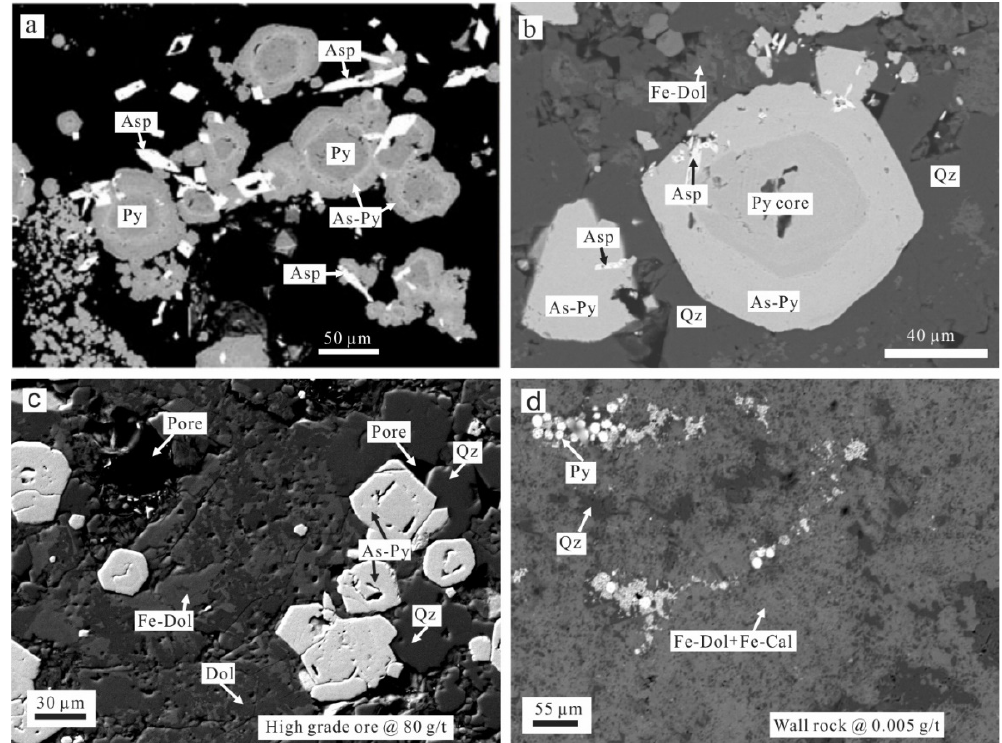
Figure 7. Backscattered electron (BSE) image of selected ore as well as wall rock from Shuiyindong. ( a,b ) BSE image of ores containing zoned arsenian pyrite (showing As-rich rims on As-poor pyrite cores) and arsenopyrite (after Su et al. [5,38] ). ( c ) BSE image of high-grade ore showing decarbonatization and high porosity. ( d ) BSE image of wall rock showing no decarbonatization and nonporous. Abbreviations: Asp—arsenopyrite, As-py—arsenian pyrite, Dol—dolomite, Fe-Cal—ferroan calcite, Fe-Dol—ferroan dolomite, Py—pyrite,